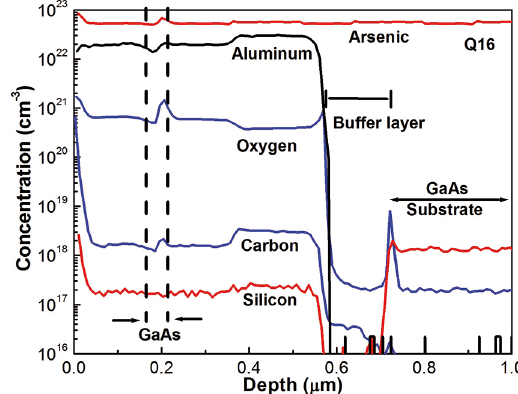
Figure 10: Residual impurity concentration profiles of a typical sample measured by SIMS. Variations of aluminium concentration in the film during growth did not result in increasing oxygen